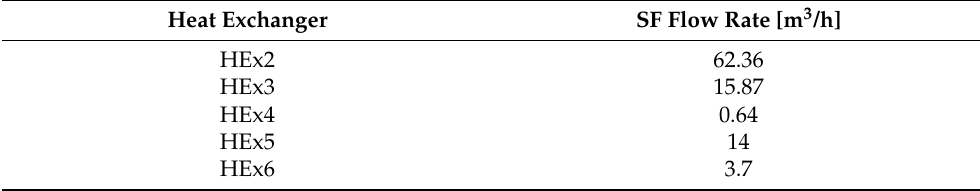
Table 7. Average SF flow rate in 20–22 January 2020.